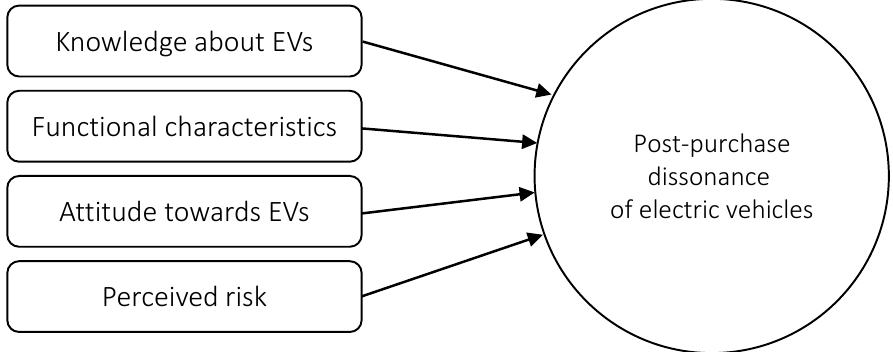
Figure 1. Research